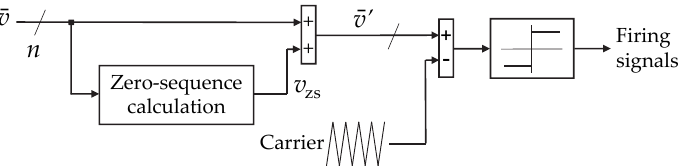
Figure 25. Block diagram of the CB PWM implementation of zero-sequence injection 1ZS or MZS, using (2) for computing v zs [343].